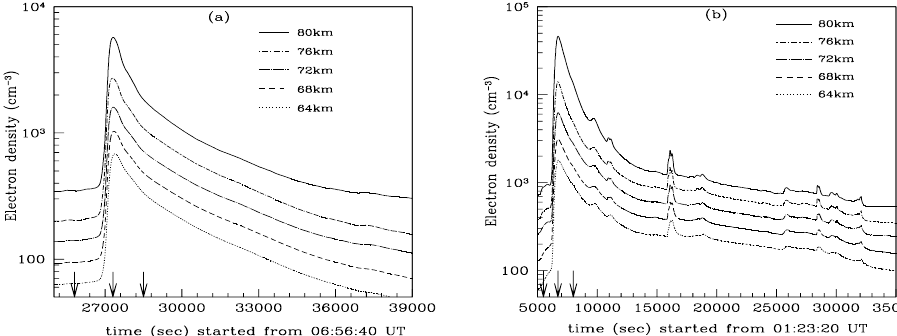
Fig. 6. Electron density at different layers during the (a) M-class and (b) X-class flares.